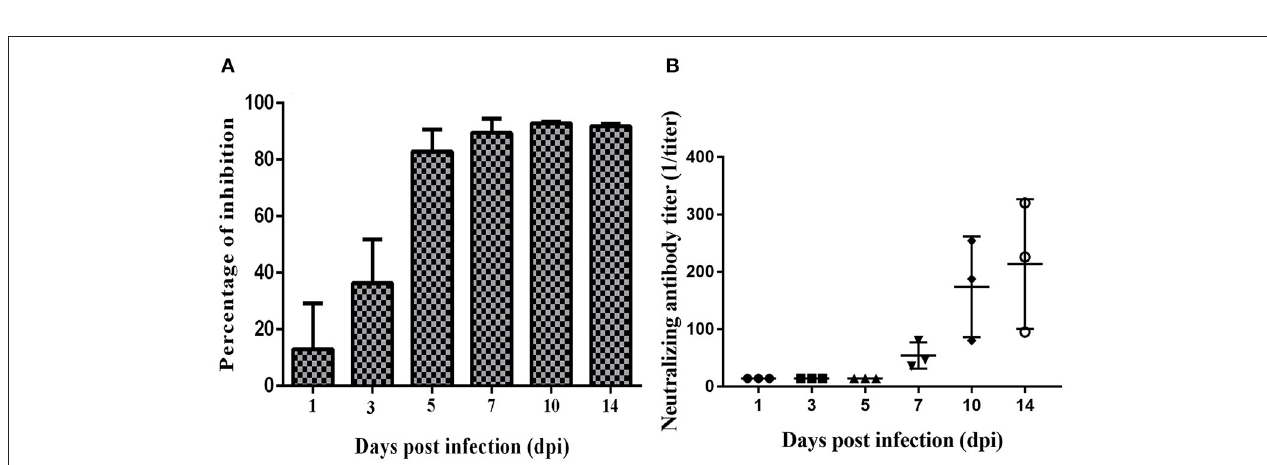
FIGURE 4 | Changes of anti-Senecavirus A (SVA) serum antibody levels during SVA infection. (A) Anti-SVA serum antibody detected with cELISA. (B) The dynamic change of neutralizing antibody detected with neutralization